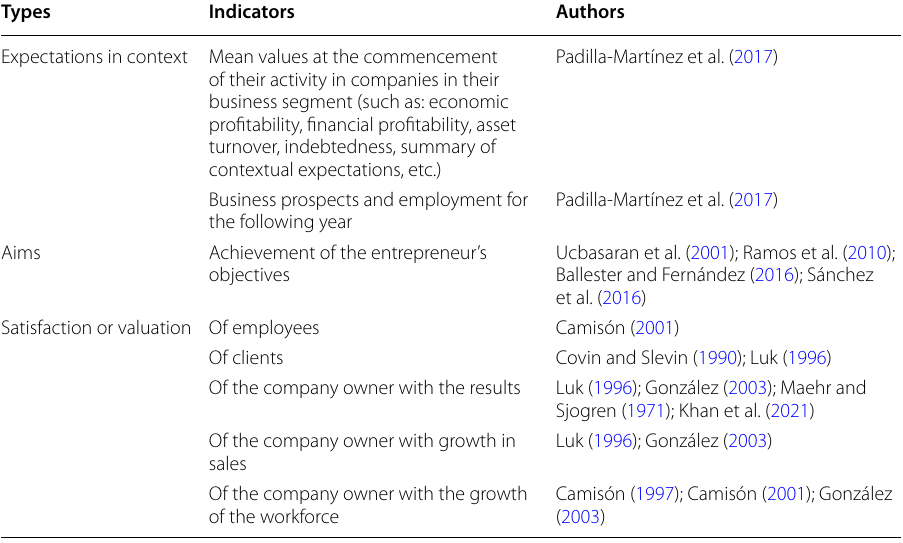
Table 2 Some indicators to measure